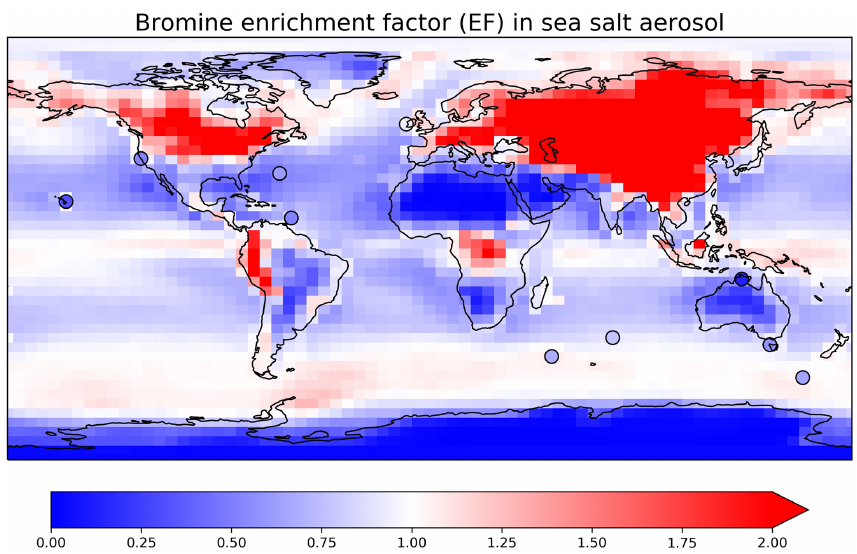
Figure 4. Annual mean bromine enrichment factor (EF) of sea salt aerosol (SSA) in surface air. GEOS-Chem model results for total SSA (contours) are compared to observations (circles). We sum [Br − ] and [SSA] from both fine and coarse SSA and use Eq. (6) to calculate the